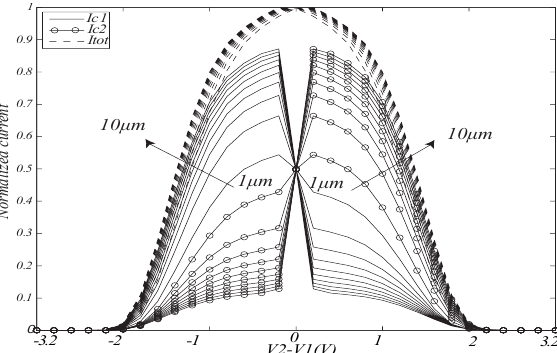
Figure 7. Simulation result of the circuit shown in Figure 5a. The widths of transistors M 1 and M 2 are increased from 1 µ m to 10 µ m simultaneously as marked by the arrows and M 3 and M 4 have a constant width of 1 µ m. The total current Itot, which is the sum of the two currents is shown as dashed curves with a clear bell shape.